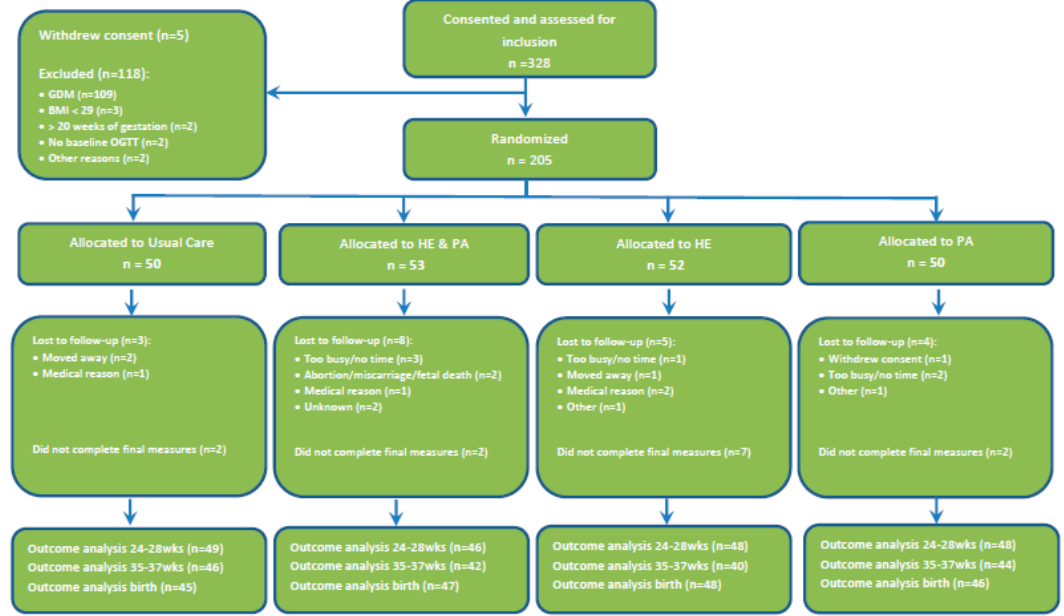
Figure 1. Recruitment flowchart for five sites achieving the greatest gestational weight gain limitation.